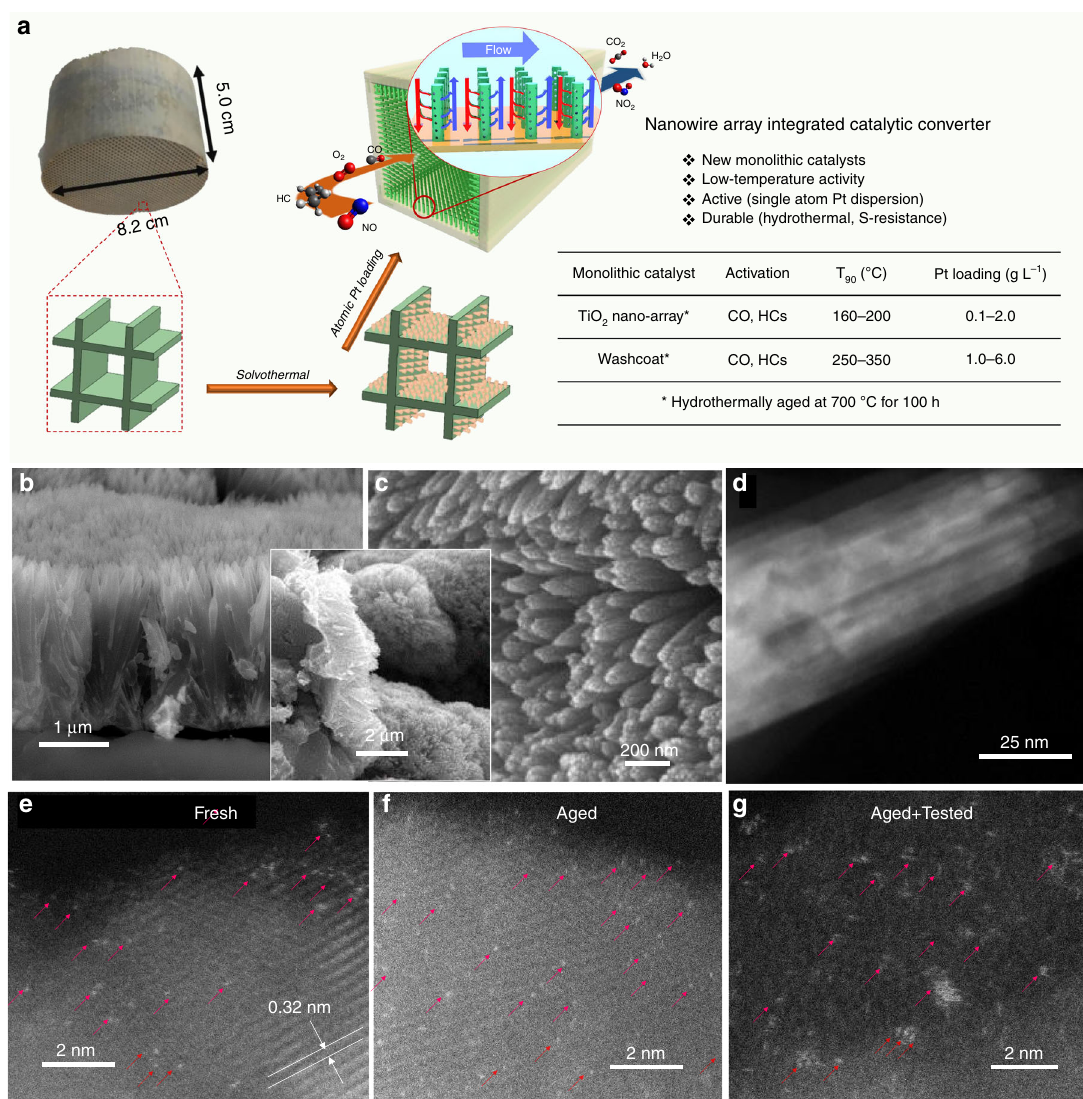
Fig. 1 Synthesis and structure of single Pt atoms supported on rutile TiO 2 nanowire arrays. a Schematic illustration of integration process of Pt 1 /TiO 2 nanowire array forest onto ceramic monoliths and physicochemical and catalytic characteristics of such DOC catalytic converters. b Cross-sectional and c top view SEM images of rutile TiO 2 NA on a cordierite honeycomb; inset: low-magni fi cation cross-sectional view of cordierite substrate interface with conformably distributed TiO 2 nanowire forest. d HAADF STEM of a rutile nanowire bundle. The arrays of dark spots on the HAADF STEM image identi fi ed the mesoporosity of the TiO 2 nano-arrays. e – g ac-HAADF STEM images of Pt 1 /TiO 2 NA prepared by microwave-assisted dip-coating (0.71 g Pt L − 1 ) ( e ) before, ( f ) after hydrothermal aging at 700 °C for 100 h, and ( g ) after hydrothermal aging at 700 o C for 100 h followed by simulated CDC exhaust test treatment. The bright dots on the surface of TiO 2 are Pt atoms, as pointed by red